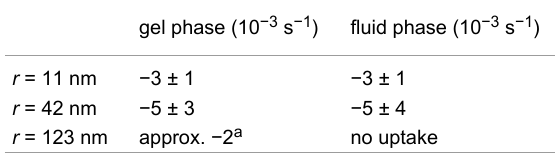
the initial vesicle radius R